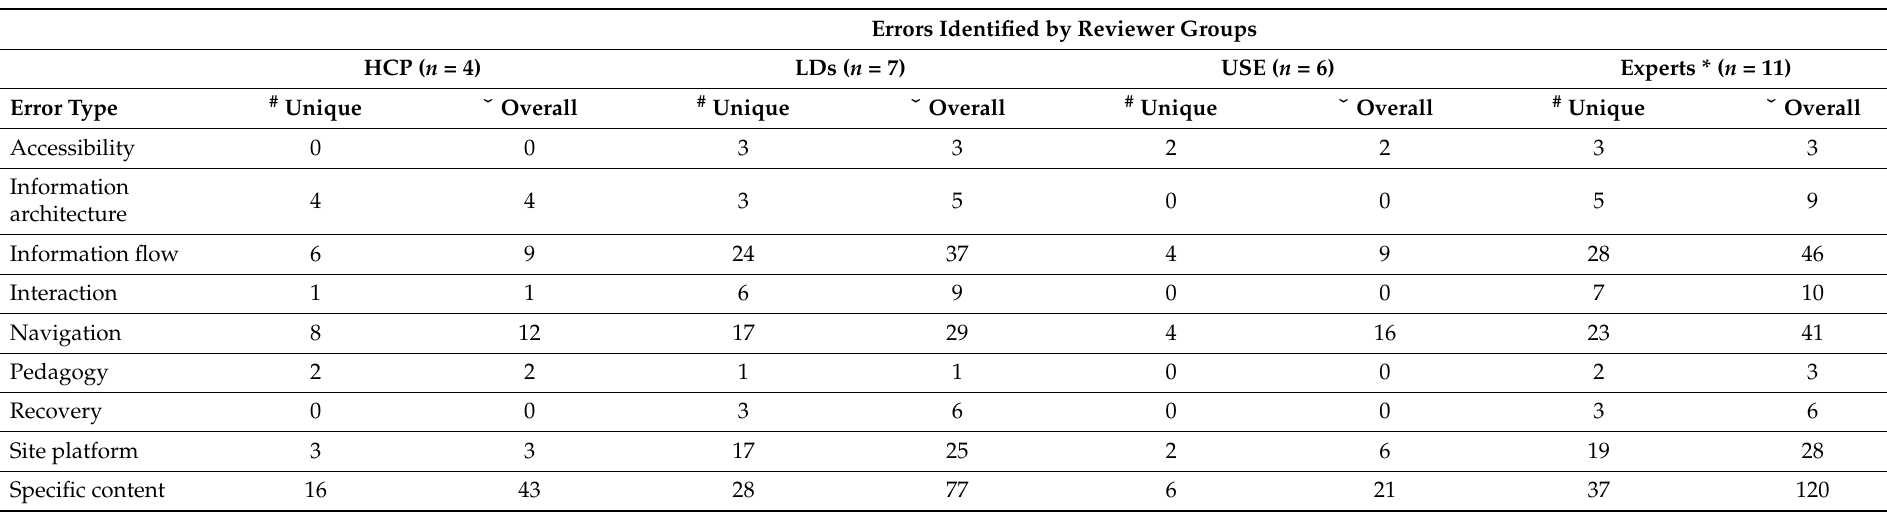
Table A3. Frequency of overall and unique errors identified by carers (USER) and EXPERT (HCP and LD) evaluator